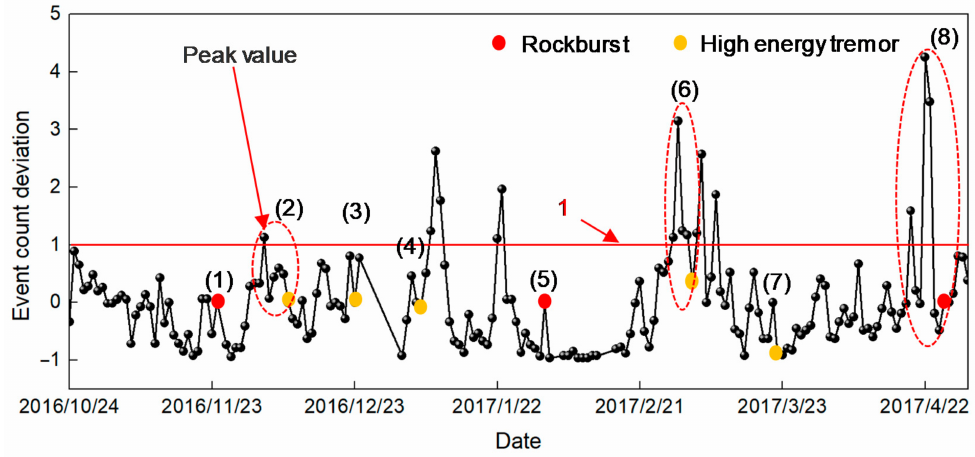
Figure 9. Event count deviation temporal evolution law before and after the rockbursts and high energy